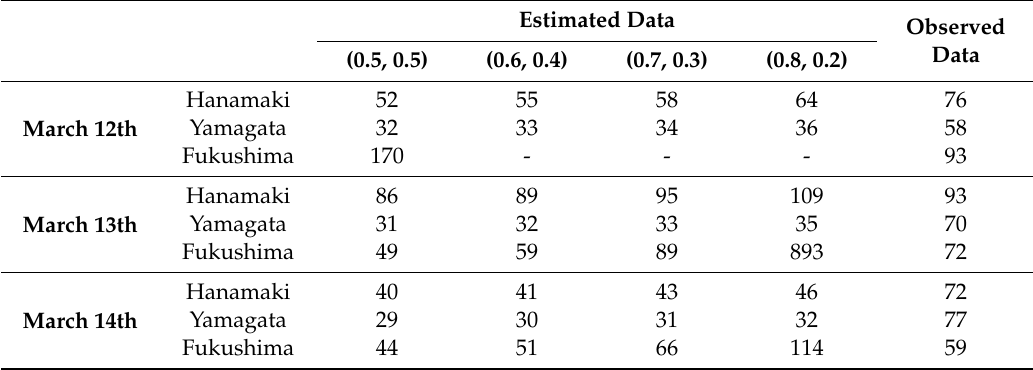
Table 9. Transition probability adjustment (each activity to refueling, each activity to runway) and aircraft waiting time in each airport (unit: